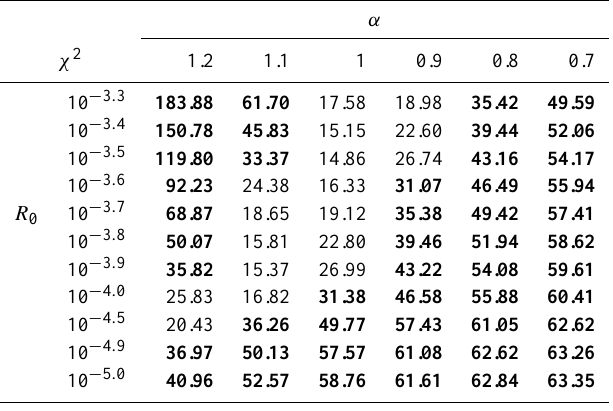
Table 7. χ 2 values among X trend and X theor values obtained for the case of 5 September 2012. Bold values are greater than the obtained critical value.